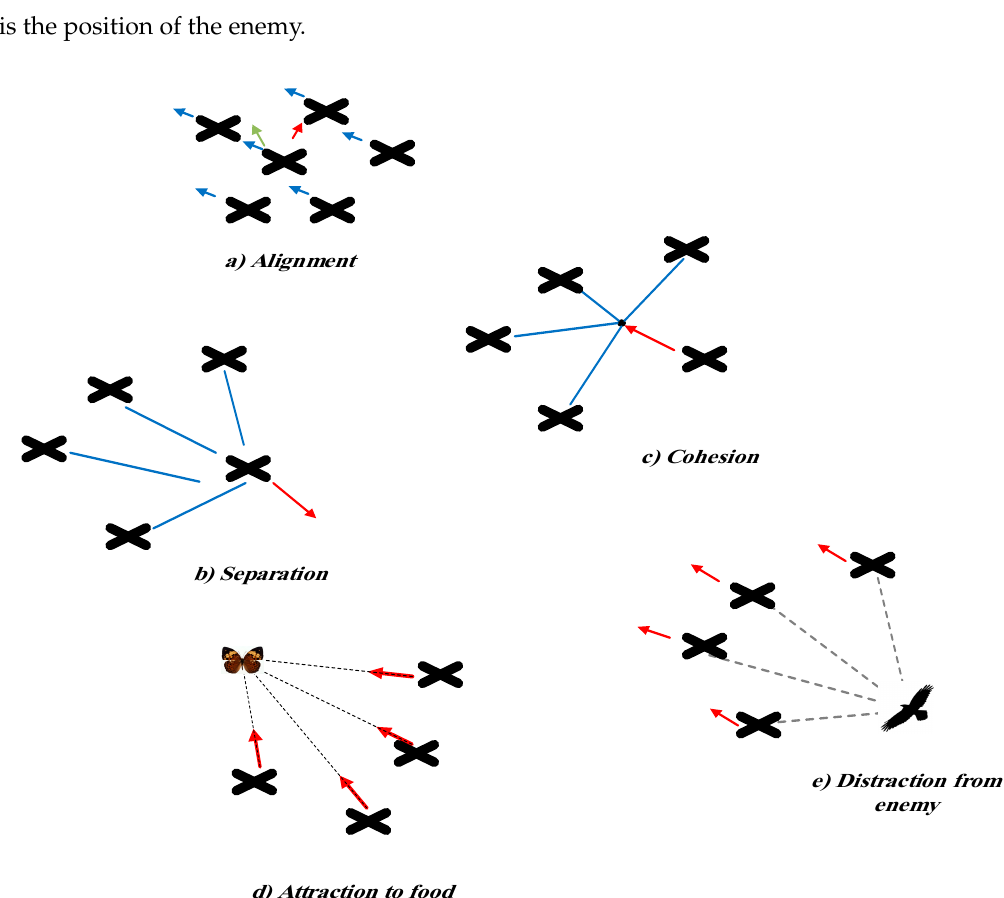
Figure 1. Five factors in position updating of individuals in swarms.